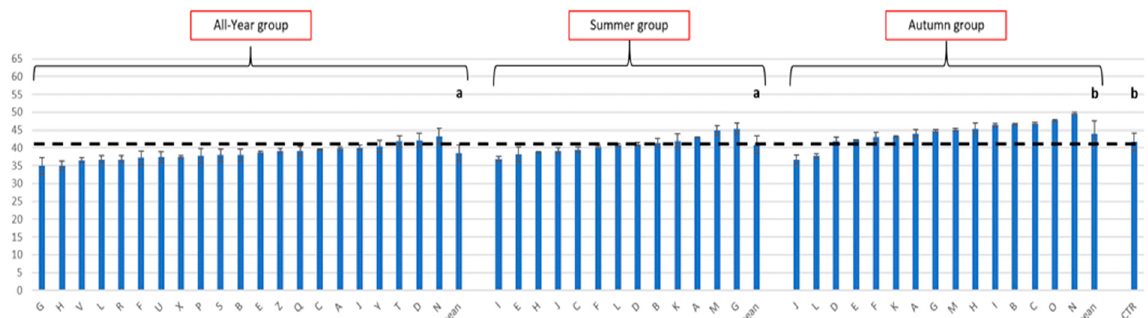
Figure 1. Total protein content (Nx4.67, g/100 g DM) for each BSF sample grown on the 49 diets considered and compared with the control samples (dotted line). Each datum is the mean of two replicates. Global mean of each group was compared with one-way ANOVA ( p -level 0.05). Different letters ( a , b ) on the bars indicate significantly different values.